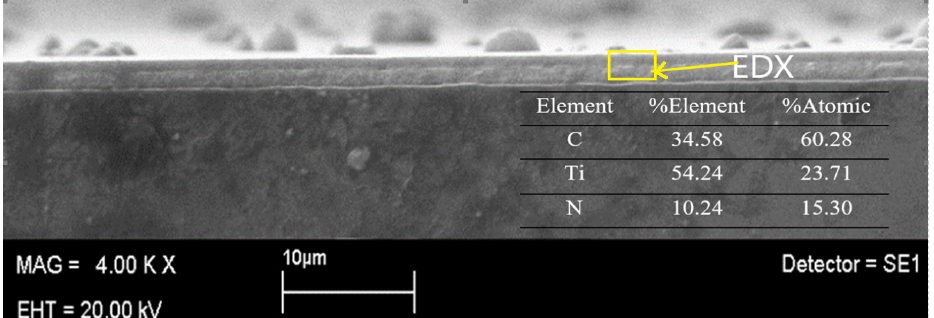
Figure 3. Scanning electron microscope image and energy dispersive X-ray analyses of the TiCN coating thickness.